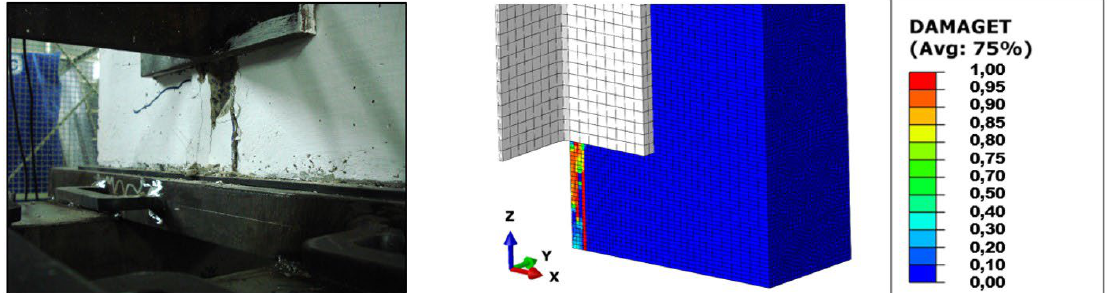
Figure 15. Concrete cracking in front of the shear